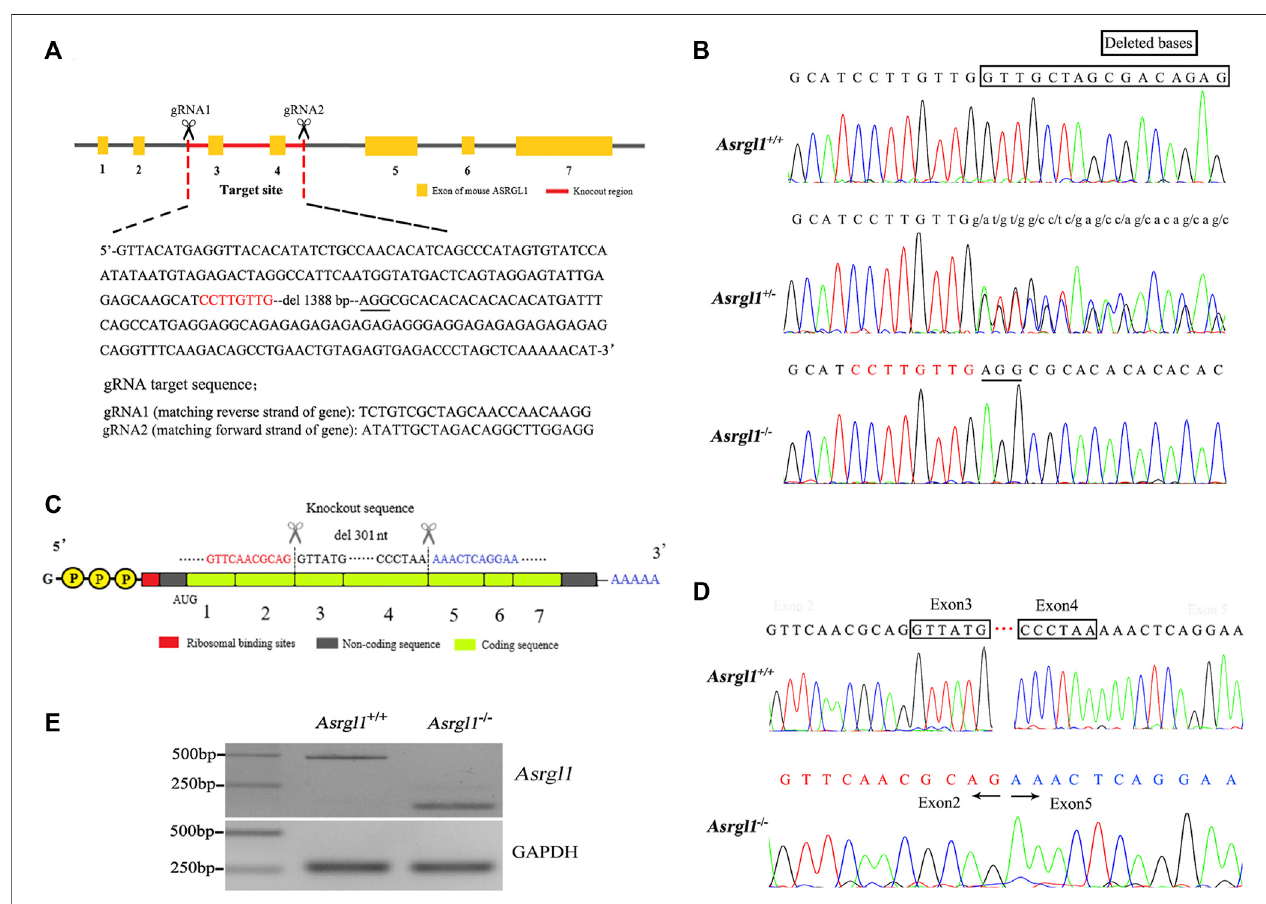
FIGURE 1 | Generation of Asrgl1 knockout (KO) mice. (A) The partial genomic sequence of Asrgl1 exons was shown. The 1,388-bp genomic deletion was indicated in red. (B) Sanger sequencing of Asrgl1 genome in the wild-type (WT), Asrgl1 +/ − and Asrgl1 − / − mice. (C) Schematic illustration of cDNA deletion in Asrgl1 KO mice. (D) Sanger sequencing of Asrgl1 cDNA in WT and Asrgl1 − / − mice. A 301-bp fragment consisting of exon 3 and 4 is deleted in Asrgl1 KO allele. (E) Reverse transcription PCR analysis of Asrgl1 expression in WT and Asrgl1 − / − mouse retinas at 3 months of age. Gapdh was used as a loading control.